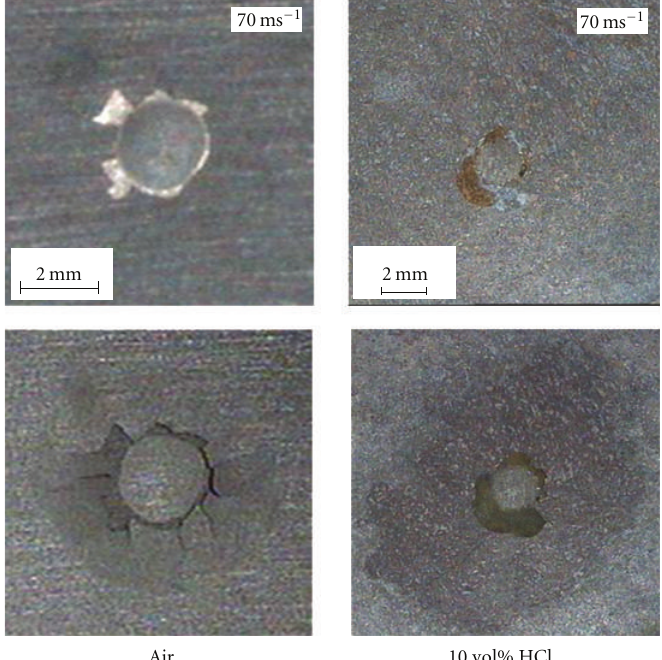
Figure 5: Appearances of oxide films formed on Ti alloy in various environments at 973 K (upper photographs) and at about 10 hours after the impact (lower photographs).